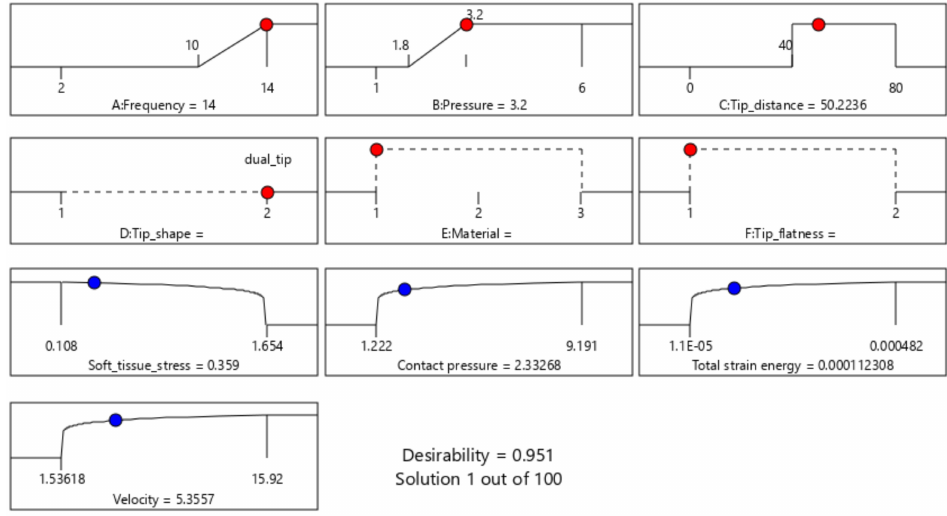
Figure 9. Numerical optimization proposed solution regarding the optimal tip